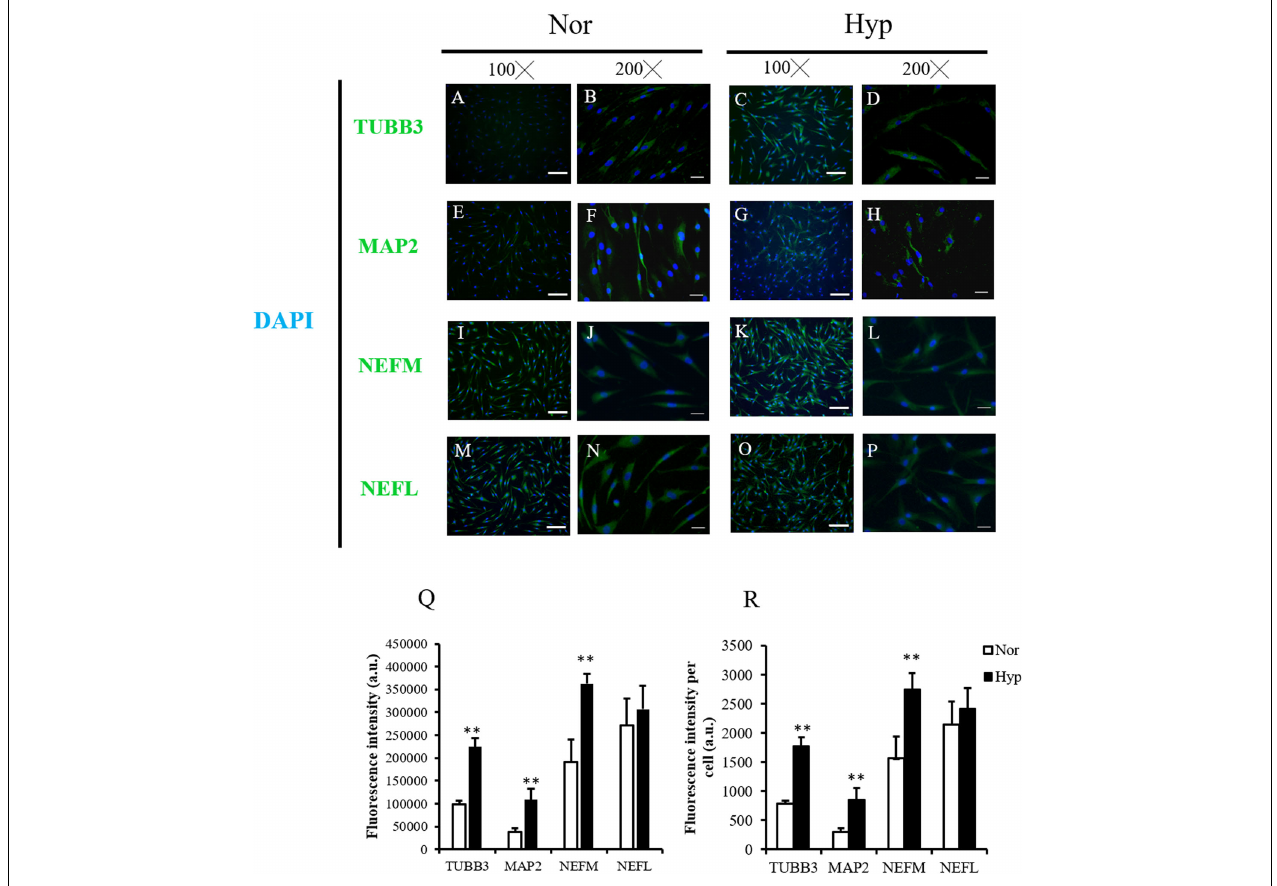
FIGURE 3 | Neuron marker detection of the normoxic and hypoxic ADSC differentiated neuron-like cells. (A–D) Class III β -tubulin (TUBB3), (E–H) microtubule-associated protein 2 (MAP2), (I–L) neurofilament medium polypeptide (NEFM), and (M–P) neurofilament Light polypeptide (NEFL) of the normoxic and hypoxic ADSC differentiated neural-like cells on day 7 of differentiation were stained by immunofluorescence staining (Magnification × 100; the scale bar = 100 µ m; magnification × 200; the scale bar = 50 µ m). (Q) Total immunofluorescence intensities of 120–150 cells from six fields were quantified by the Image-Pro Plus v4.5.0.29. The intensity of each cell was also calculated (R) . Values are presented as mean ± SD with three replicates of the experiments. Statistical significances between the two groups were analyzed using the Mann-Whitney U -test. “ ∗∗ ” represented P <